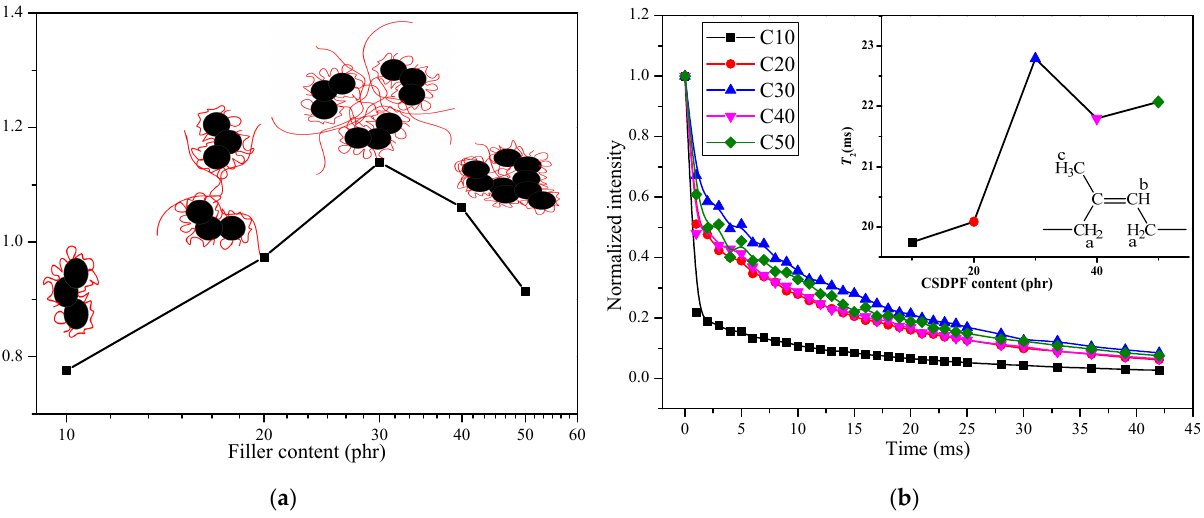
Figure 2. ( a ) BdR of CSDPF/NR compounds, ( b ) Spin–spin relaxation and T 2 of Hb nuclei (inset image) in bound